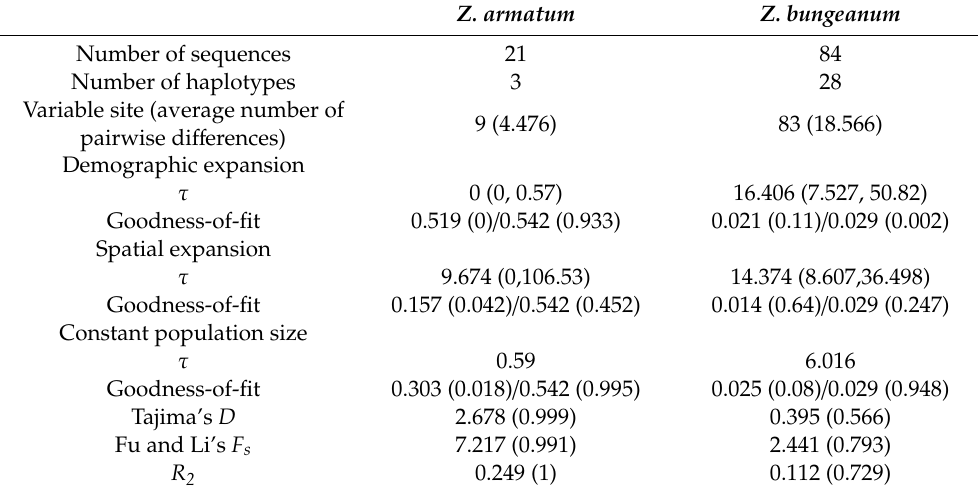
Table 3. Pairwise sequence divergence statistics (mismatch analysis) based on frequency of haplotypes and test statistics of neutrlity of Z. armatum and Z. bungeanum sampled in this study. Z. armatum Z. bungeanum